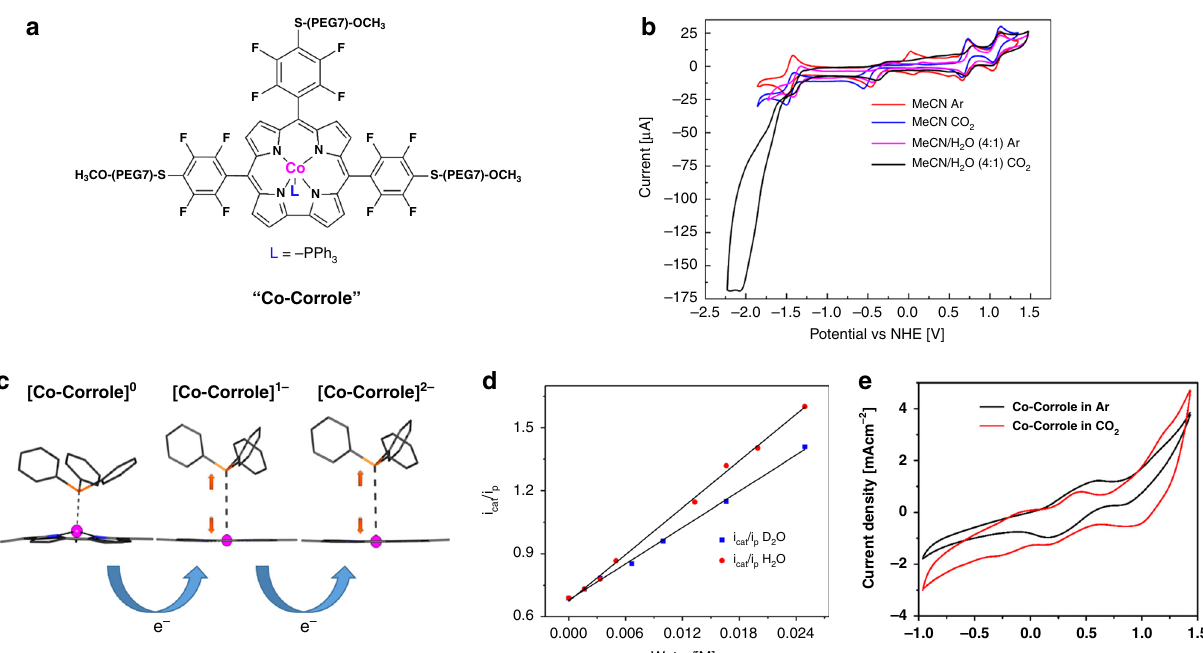
Fig. 1 a Chemical structure of the Co-corrole. b Cyclic voltammetry of Co-corrole dissolved in CH 3 CN under Ar (red). Two metal centered redox peaks at − 0.5 V (Co (III)/Co(II)) and − 1.5 V (Co(II)/Co(I)) vs. NHE could be identi fi ed. The irreversibility of the redox peak at − 0.5 V is likely due to the partial loss of the PPh 3 ligand. Cyclic voltammetry of Co-corrole dissolved in CH 3 CN under CO 2 (blue), in CH 3 CN/H 2 O (4:1) under Ar (pink) and in CH 3 CN/H 2 O (4:1) under CO 2 (black). c DFT optimized geometries of [Co-corrole] 0 , 1e − and 2e − reduced species showing the movement of Co center into the central cavity of the corrole ring with concomitant lengthening of the Co-PPh 3 bond upon successive reduction. d Kinetic isotpopic effect demonstrated by cyclic voltammetry of Co-Corrole (0.5 mM) recorded in CO 2 saturated in acetonitrile in the presence of varying amount of H 2 O or D 2 O. Linear dependence of i i √ k = k = (Slope 2 = (37.1057/28.7545) 2 = 1.67). cat / p on the concentration of water (analogous to plotting CO2 vs. [water], KIE CO2H /k CO2D H2O /slope D2O ) All cyclic voltammograms were recorded with 0.1 M TBAPF 6 as supporting electrolyte using a glassy carbon as working electrode and a Ag/AgCl as reference electrode at a scan rate of 100 mV s − 1 . e Heterogeneous catalysis of 1 mM Co-corrole on carbon- fi ber electrode under Ar (black) and CO 2 (red) at pH = 6.0 (Ag/AgCl/KCl, Pt, 0.1 M NaClO 4 , 100 mV s − 1 curve) dissolved in CH 3 CN/H 2 O (4:1) shows compared with Co-